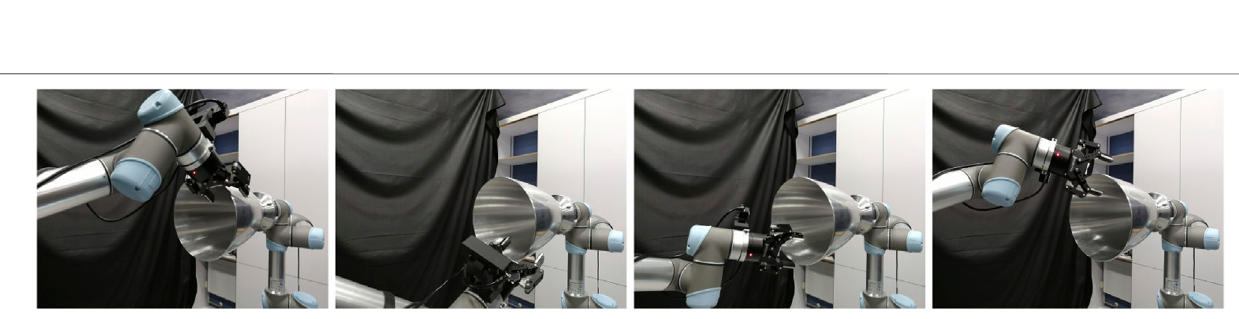
FIGURE 12 | The seven grasps generated by manually placing the robot gripper on the